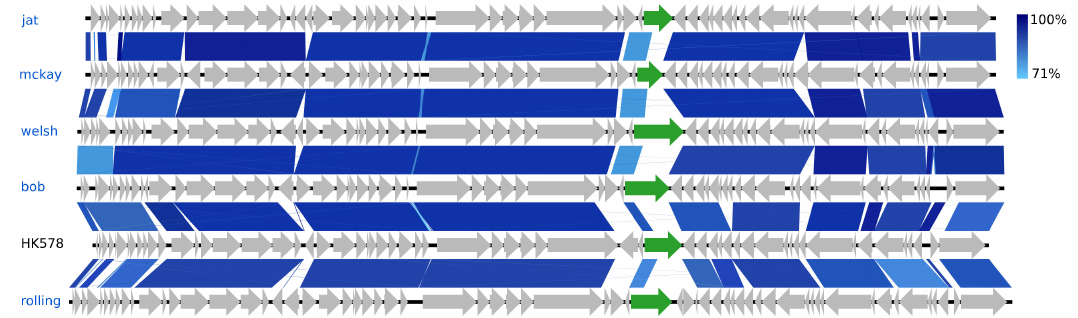
Figure 6. Pairwise alignment of the new Dhillonvirus phage species (blue text) and the type species HK578 (black text); the colour bars between genomes indicate percent pairwise similarity (Easyfig, BlASTn). Genomes have been modified to have similar starting points. Highlighted genes (green) code for a putative tail fiber.